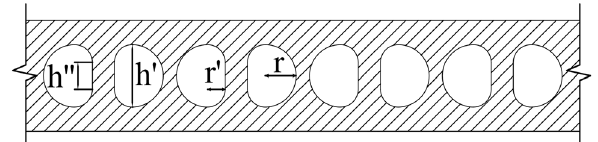
Fig. 9 Assumed section of the donut-type voided slab for calculating the moment of